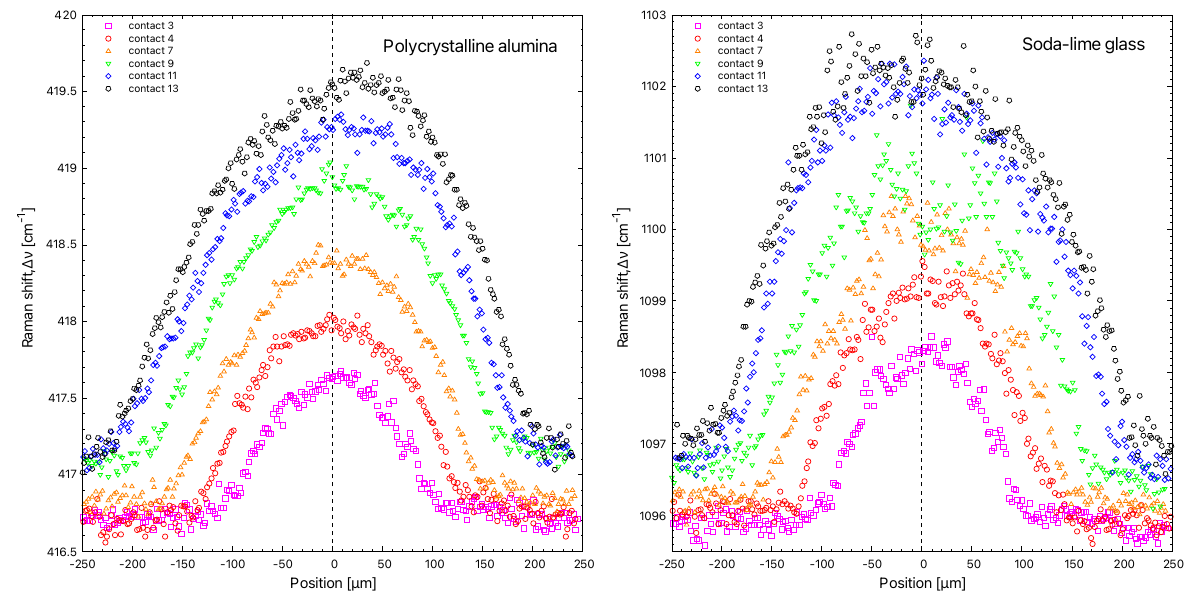
Figure 7. Raman band shift as a function of contact position for polycrystalline alumina ( left ) and soda–lime glass ( right ).